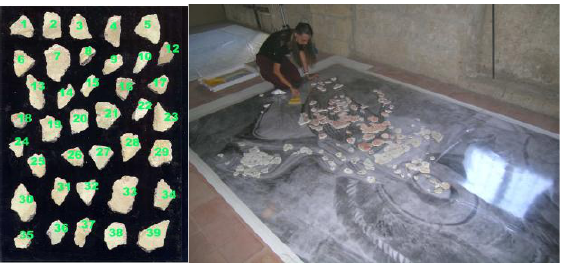
Figure 15. The catalogued fragments and the first mosaicking on enlarged photo (courtesy of ISCR and Werner Matthias Schmid)